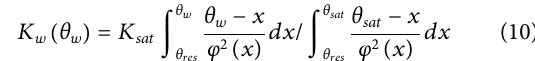
Frontiers in Earth Science |